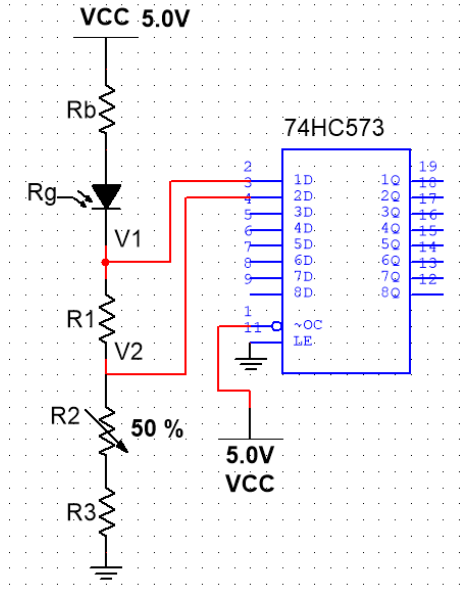
Figure 5. Decoding circuit for one LCD pixel.